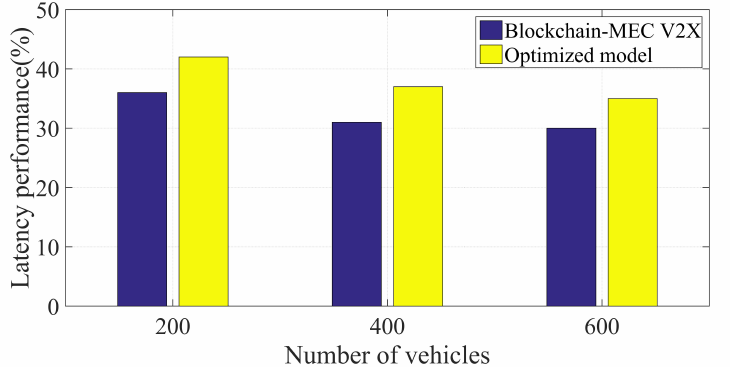
Figure 7. Latency performance of the developed systems compared with the traditional systems, for different values of deployed vehicles.